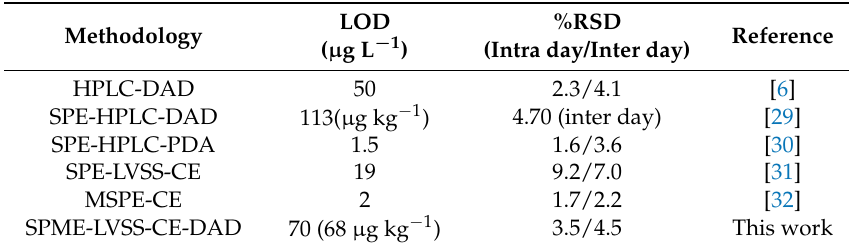
Table 2. A comparative table of analytical parameters for different determination methods described for OT analysis in milk samples.